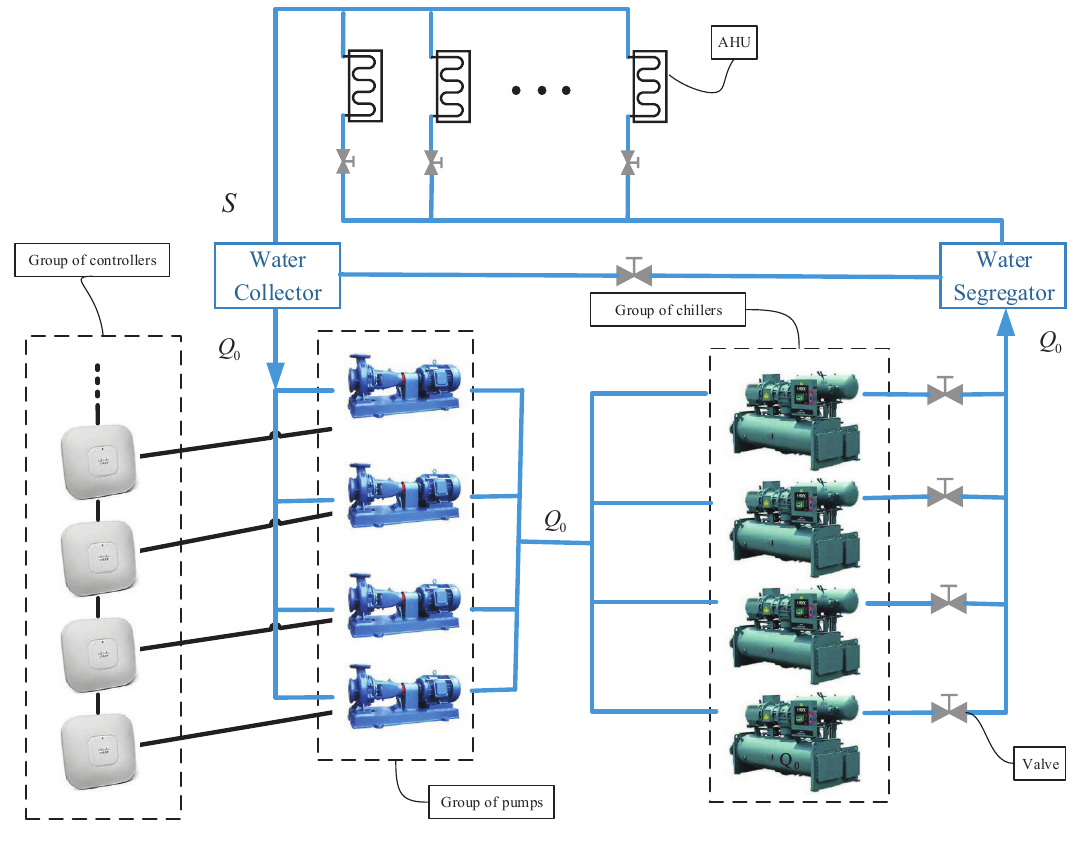
Figure 1. The distributed control framework for parallel-connected pumps.